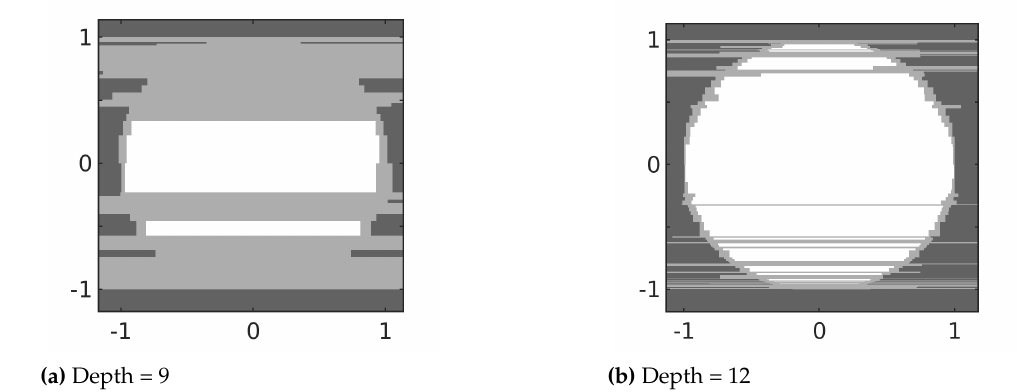
Figure 4. The polygons generated by TRE − PAN for the circle function f with a radius of 1 when the maximum tree depth is set to ( a ) 9 and ( b ) 12. The dark and white-shaded polygons define the boundaries of the negative and positive samples, respectively. The medium shaded polygons represent uncertain